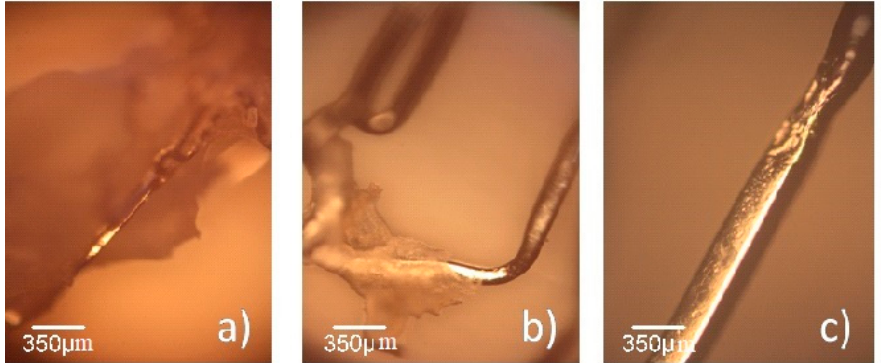
Figure 2. Light microscopy images with the detachment of tissue from stent at various times intervals. ( a ) After 1 day; ( b ) after three days; ( c ) after seven days.